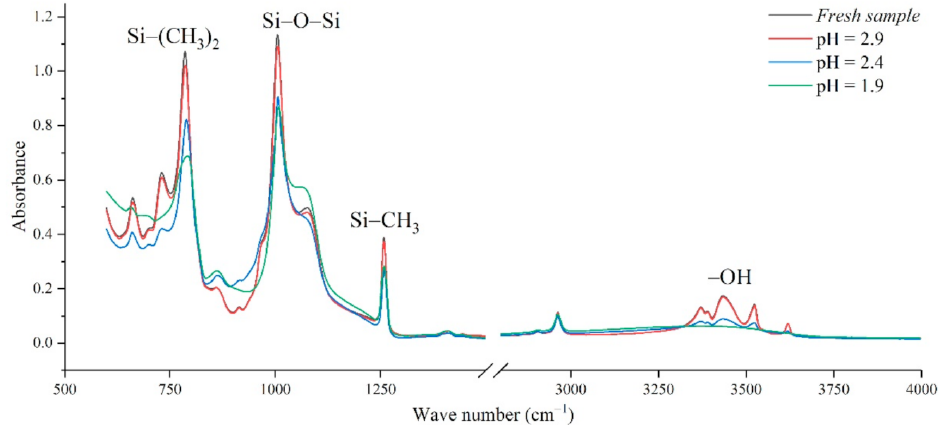
Figure 12. FTIR test results of different pH values (AC 4.86 kV, t = 8 h).